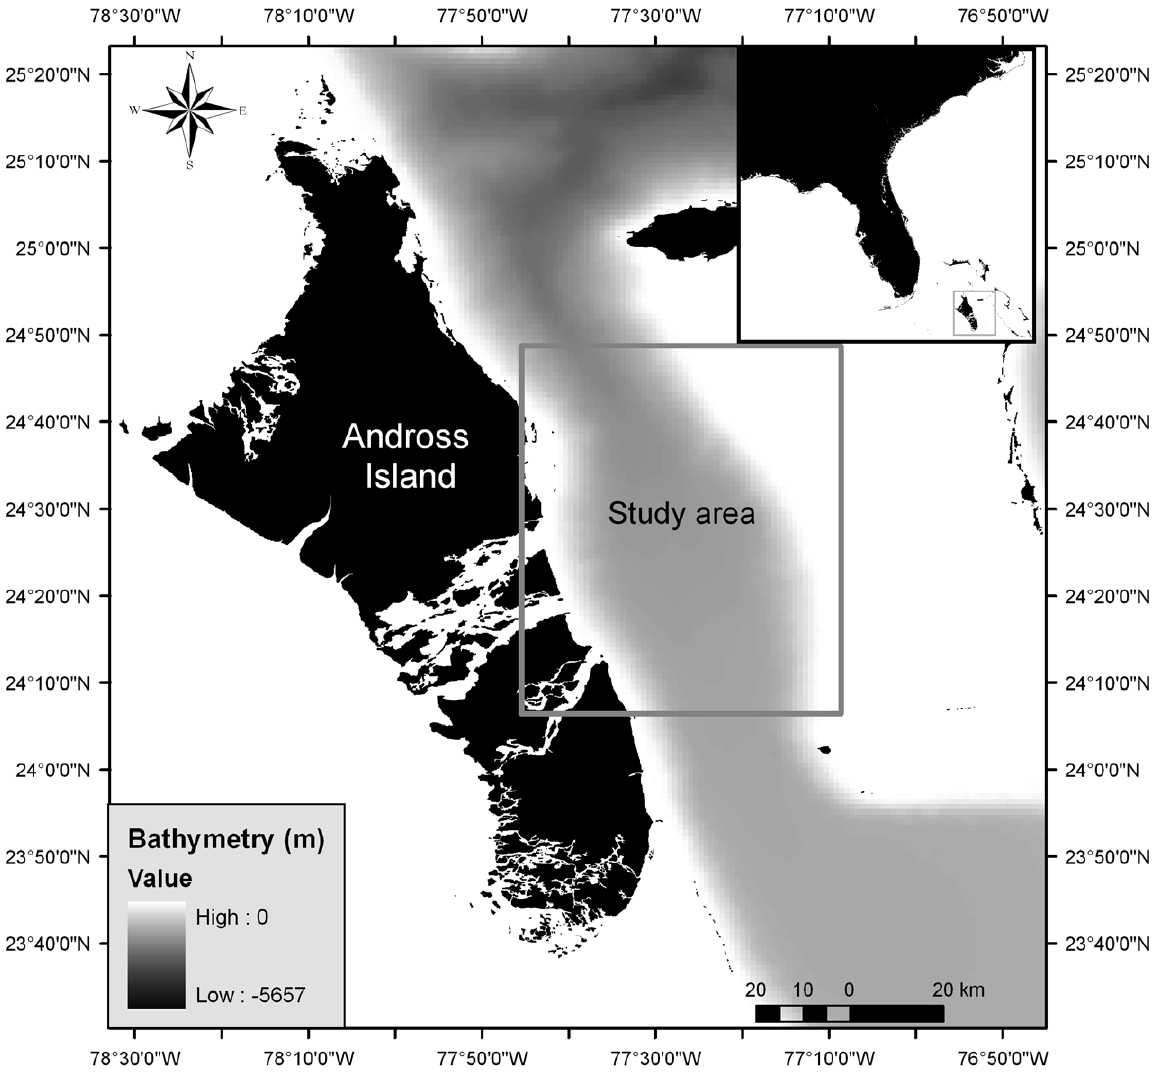
Figure 1. The Tongue of the Ocean and study site off the eastern coast of Andross Island, in the Bahamas.